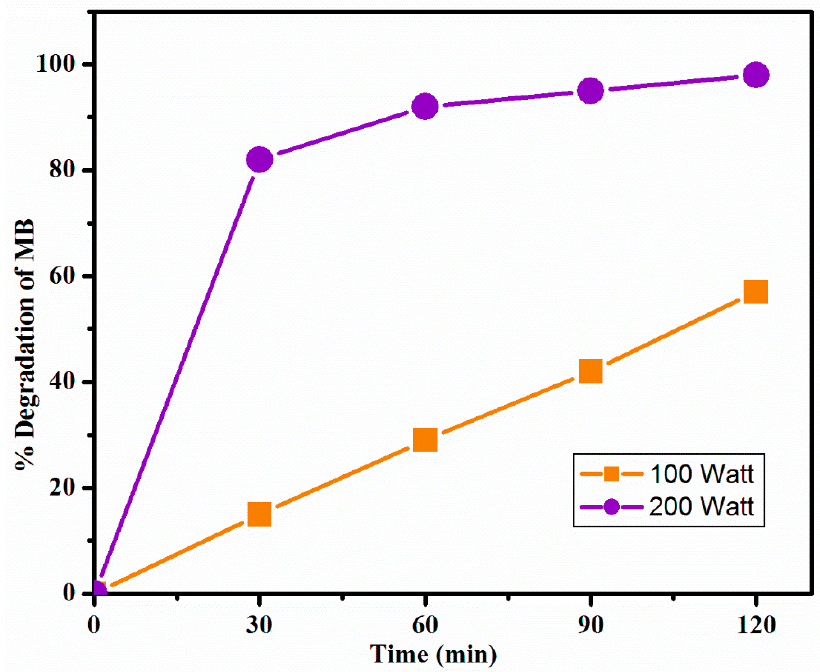
Figure 18. Percentage photodegradation of MB at various light intensities; in the presence of 100 and 200 watts visible light bulb.